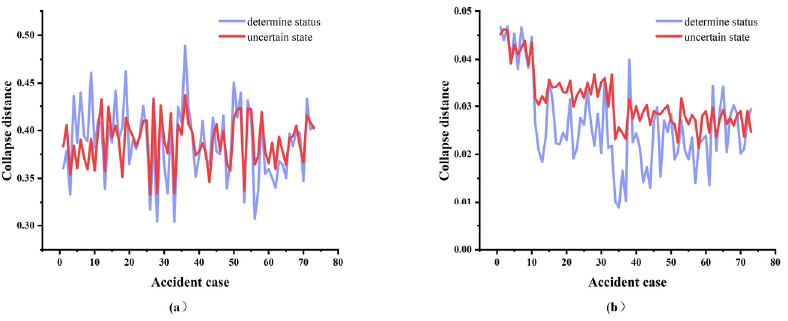
Figure 7. Variation of collapse distance in the case study. ( a ) Probability of natural occurrence; ( b ) impact probability.